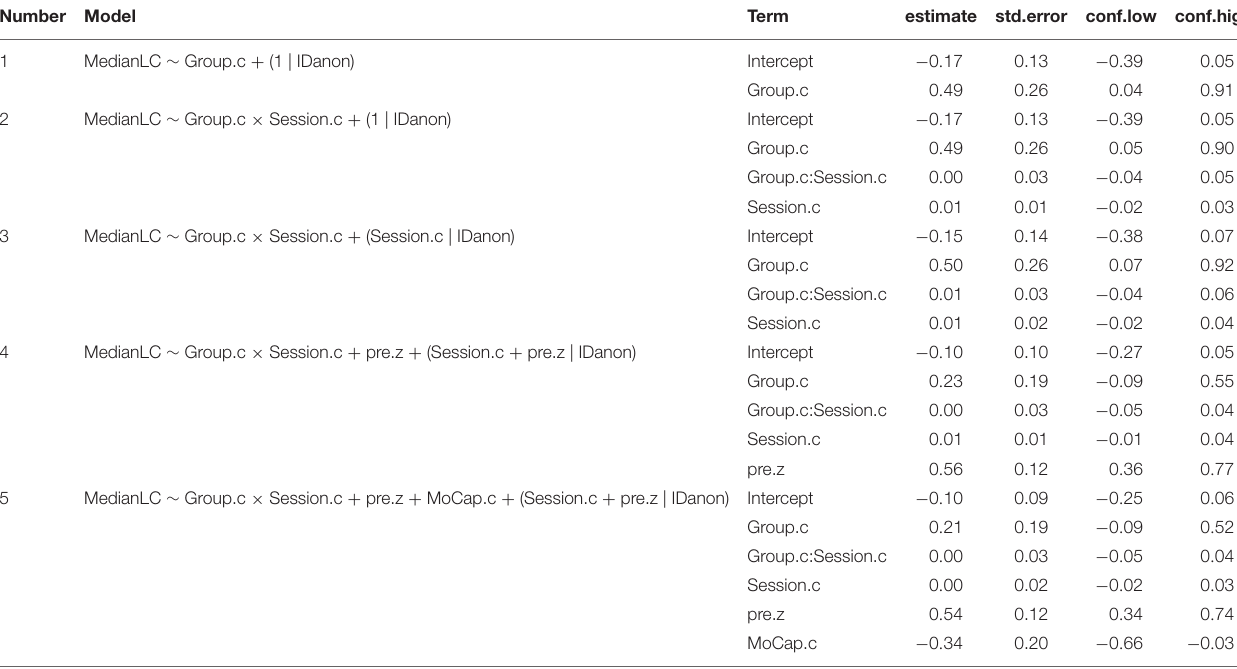
TABLE 2 | Parameter estimates of models used to explain movement smoothness over time in treatment and control groups, using two different motion capturing systems. Number Model Term estimate std.error conf.low conf.high